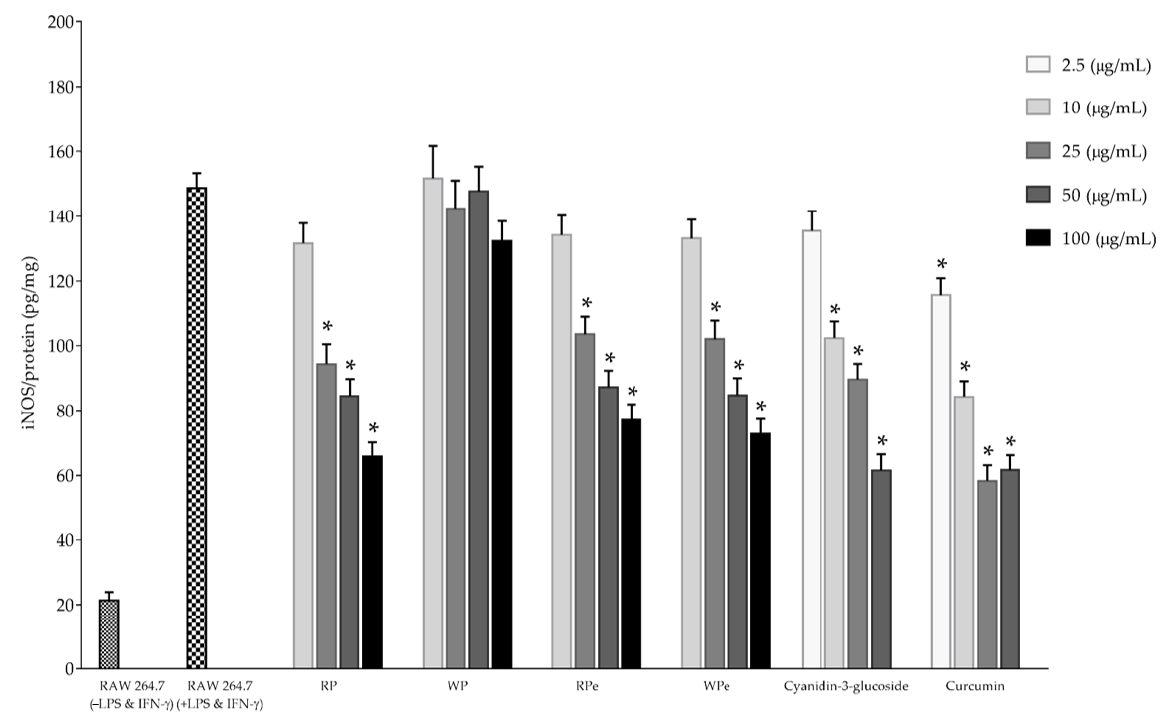
Figure 4. The inhibition effect on iNOS production in LPS/IFN-γ-induced RAW 264.7 cells of selected anthocyanin extracts (RP, WP, RPe, and WPe). * Significant differences at the 95% confidence interval compared to control RAW 264.7 cells treated with LPS and IFN-γ.